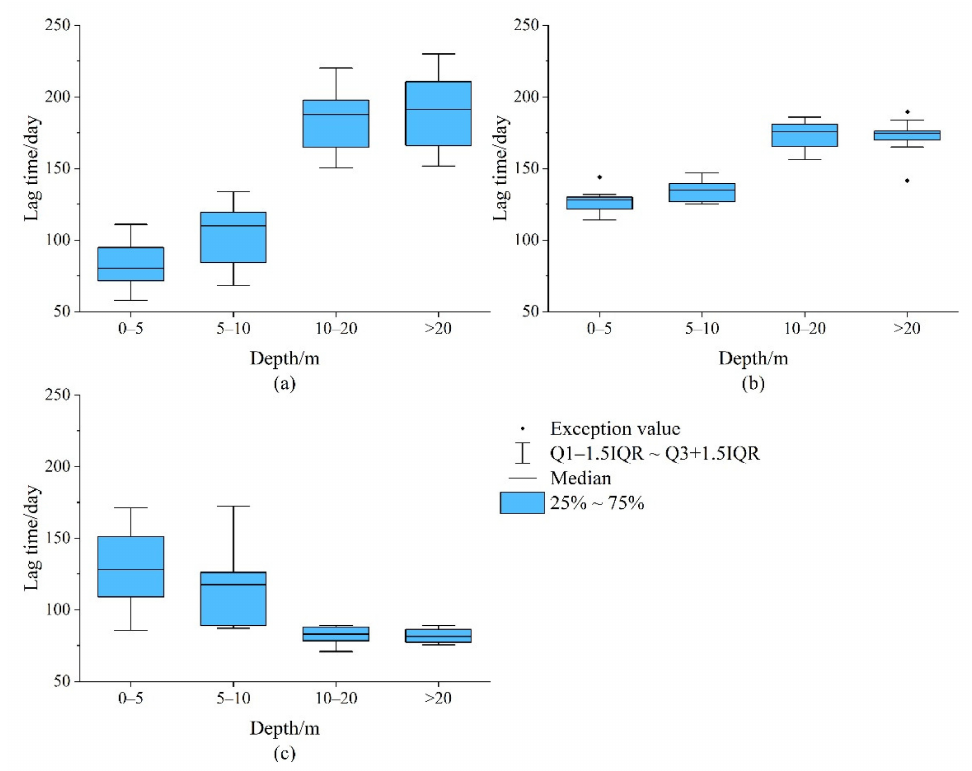
Figure 9. Box plots of delayed response time of groundwater level to the four factors under different burial depths: ( a ) Groundwater level to precipitation; ( b ) Groundwater level to air temperature; ( c ) Groundwater level to well irrigation water